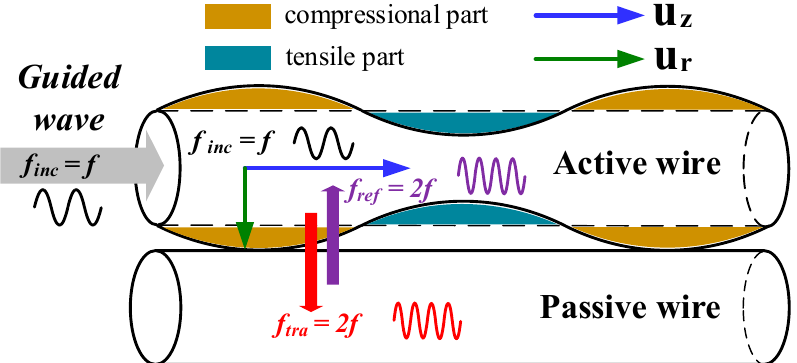
Figure 3. A schematic drawing of contact acoustic nonlinearity (CAN) at the rough contact interface of a pair of coupled cylindrical waveguides.